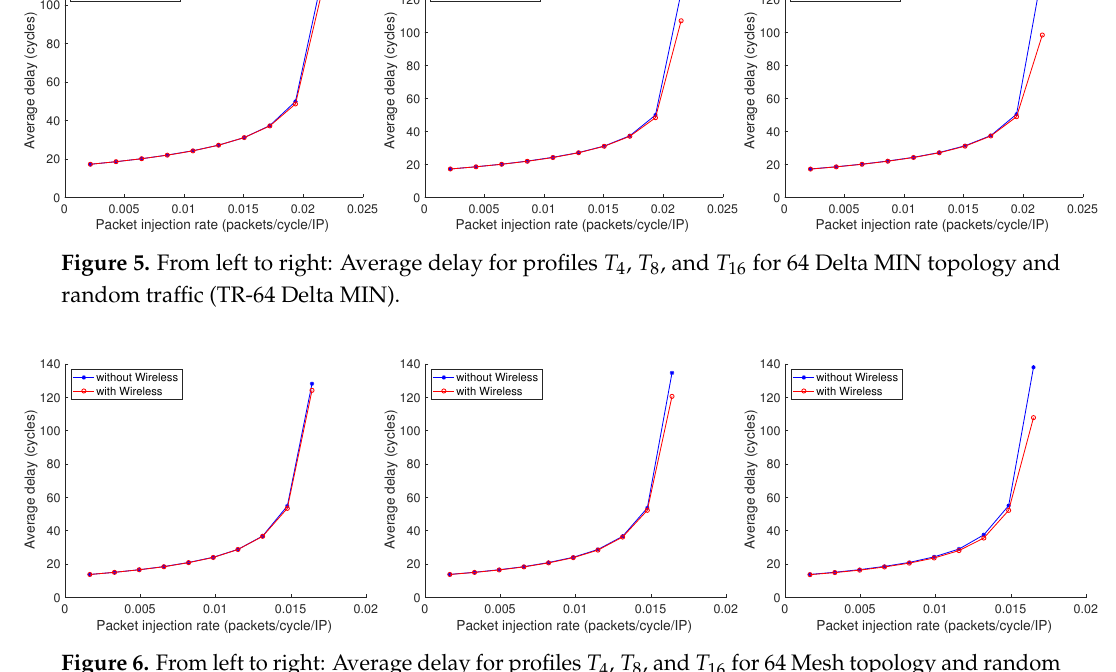
Figure 6. From left to right: Average delay for profiles T 4 , T 8 , and T 16 for 64 Mesh topology and random traffic (TR-64 Mesh).